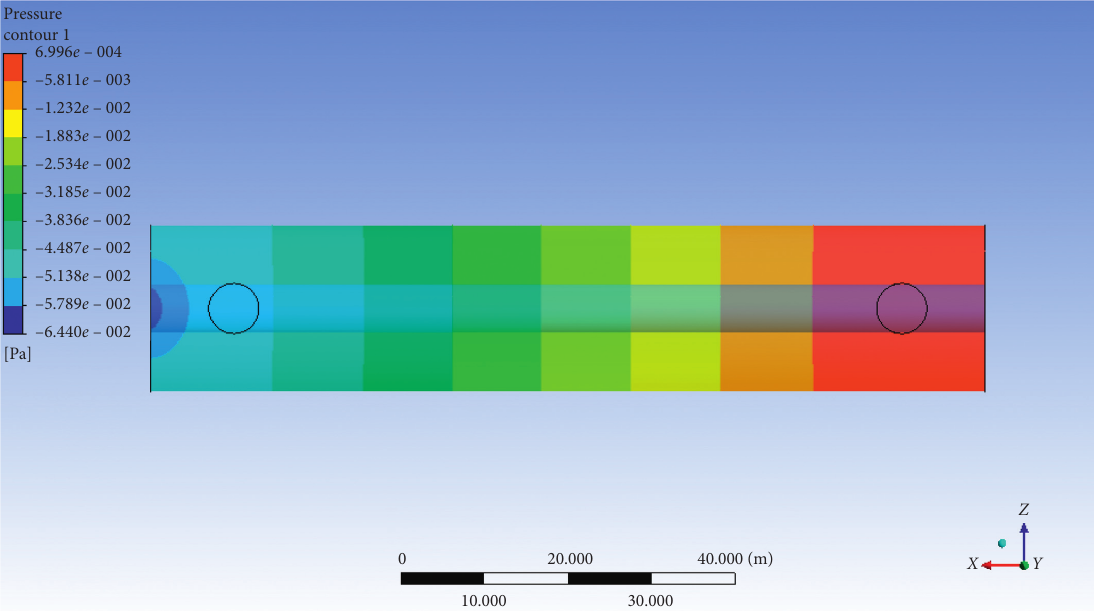
Figure 9: Pressure cloud diagram of the model cross